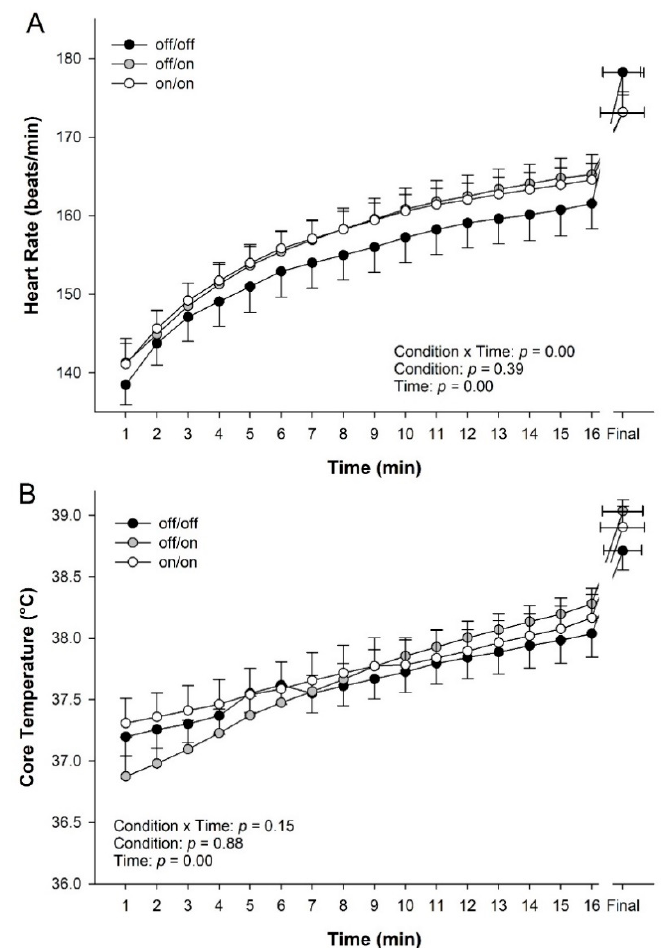
Figure 5. Physiological responses to 10 km time trial in the heat across wrist percooling condition. ( A ) Heart rate and ( B ) core temperature during 10 km time trial. Note: due to safety tolerance in core temperature, trials were ended early and plotted to the shortest time, plus each athlete’s final data point. Data are means ± Standard Error ( n = 13).